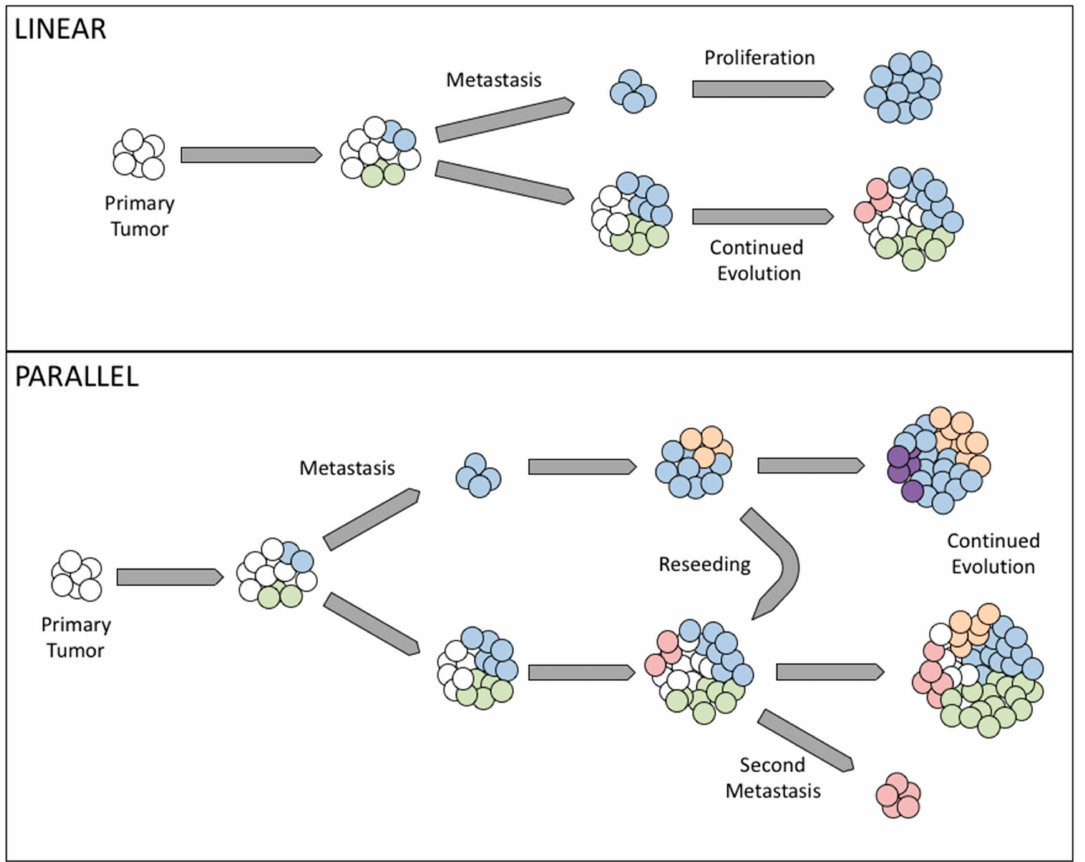
Figure 1. Comparison of linear and parallel forms of clonal evolution. Upper panel: In linear evolution, distinct populations of cells arise in the primary tumor (blue, green). Cells capable of metastasis break o ff and form monoclonal tumors in secondary sites (top blue clone). The primary tumor continues to evolve new populations (red). Lower panel: In parallel evolution, Multiple populations capable of metastasis arise at di ff erent places and times (blue, red). Both primary tumors and metastases continue to evolve, with new populations from metastases (orange, purple) arising and even reseeding the primary site